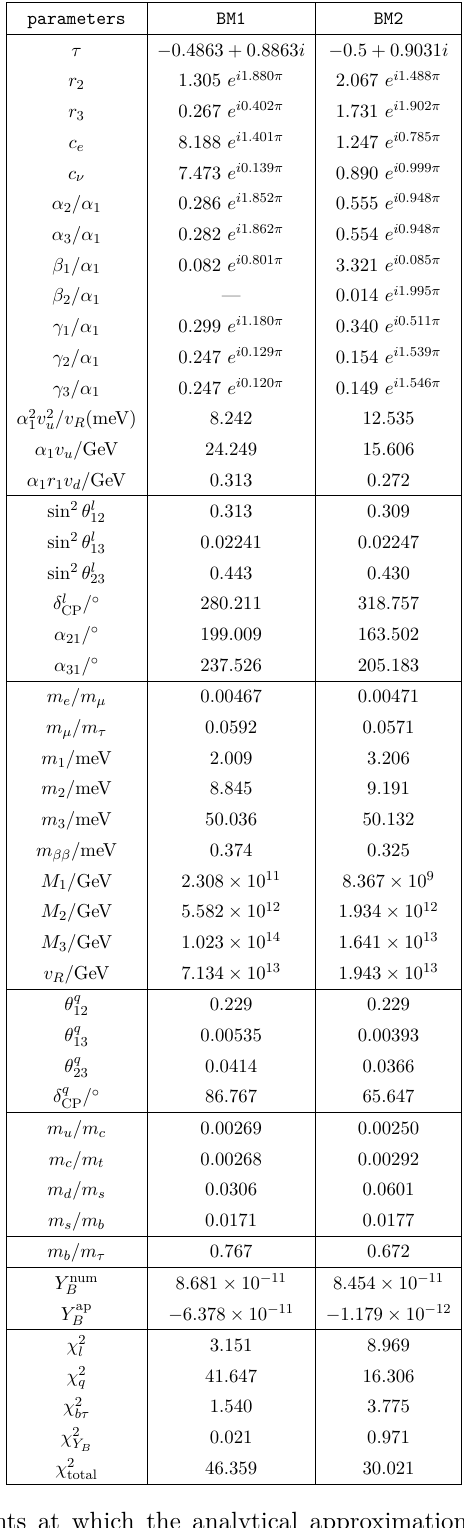
Table 5 . Benchmark points at which the analytical approximation of section 3.2 fails for the concerned models. The vanishing initial abundance of right-handed neutrinos is assumed in BM1 model while thermal initial abundance is assumed in BM2